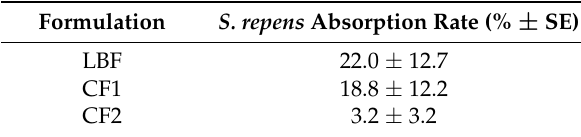
Table 6. SRO absorption rate expressed as a percentage of absorption ± standard error (SE) ( n =